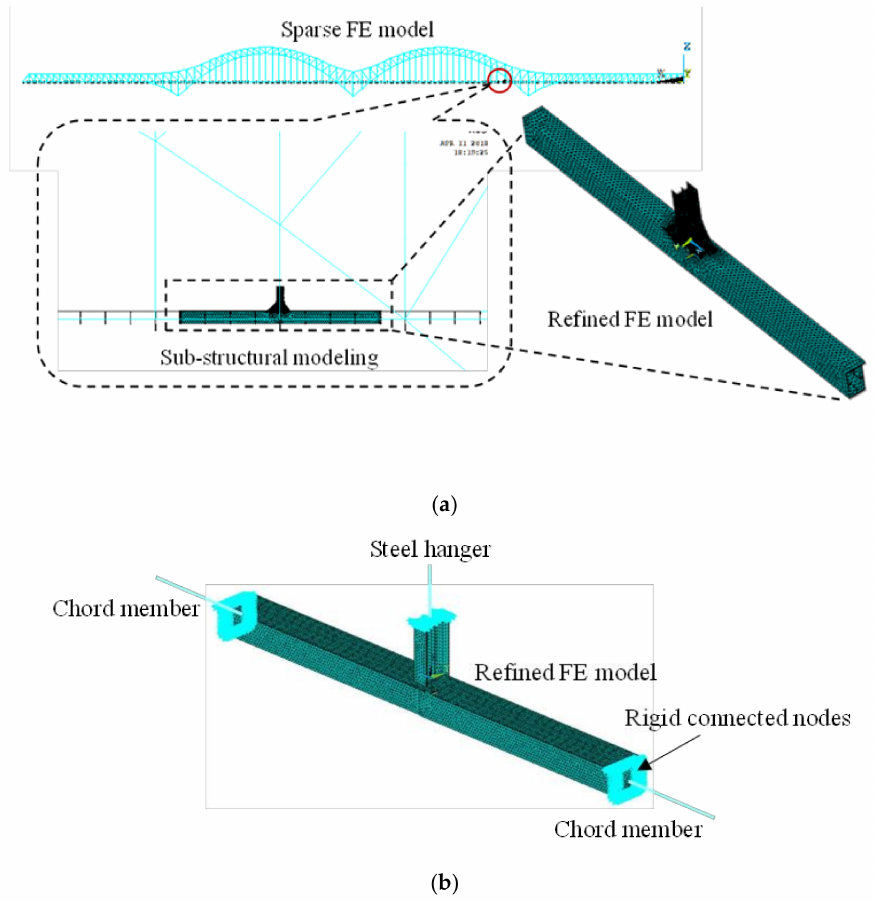
Figure 3. Two-level FE model of the high-speed railway bridge; ( a ) sub-modeling method; ( b ) refined model and connected